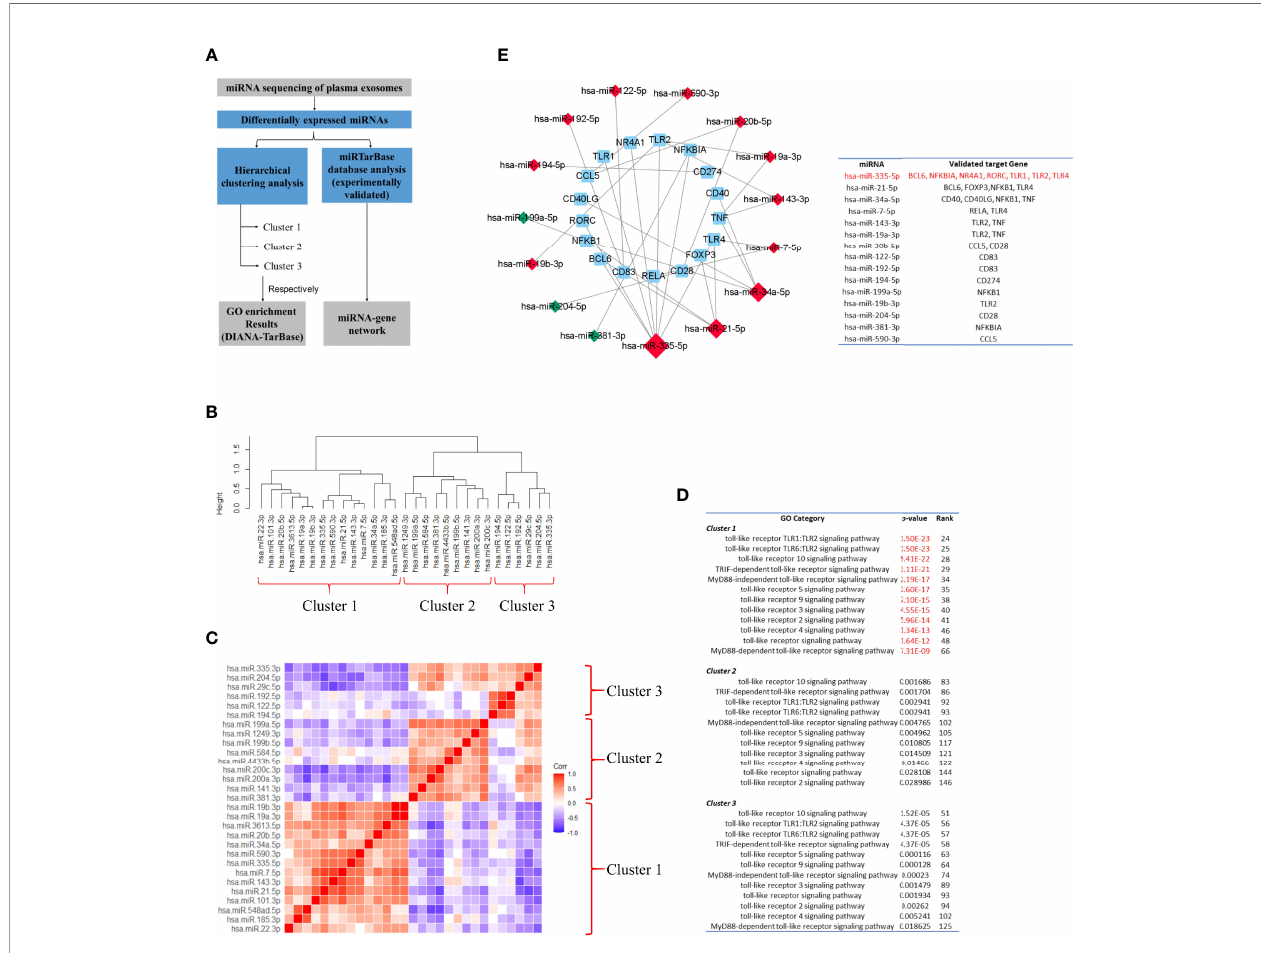
FIGURE 12 | Toll-like receptor signaling pathway might be one of the major targets of the differentially-expressed-miRNA-mediated regulation. (A) Work fl ow of miRNA sequencing analysis. miRNA was from plasma exosomes in Takayasu ’ s arteritis (TAK) patients (n=10) and healthy controls (n=5). (B) The hierarchical clustering trees of miRNA expression level based on Spearman correlation coef fi cient using complete method. (C) The hierarchical clustering heatmaps of miRNA expression level based on Spearman correlation coef fi cient. (D) GO enrichment analysis for each cluster based on DIANA-TarBase, an experimentally validated database. The results indicated that TLR signaling pathway might be one of the major targets of the differentially expressed miRNA-mediated regulation, especially of the miRNAs belonging to Cluster 1. (E) Differentially expressed miRNAs. The miRNA-Gene-network based on miRTarBase database, an experimentally validated database, and the screening condition of “ support type ” was set to “ Functional MTI (miRNA target-interactions). Red and green colors of miRNA indicated upregulation and downregulation, respectively. The results demonstrated that differentially expressed miRNAs that targeted multiple selected genes do exist in TAK, and TLRs, BCL6, and FOXP3 might be regulated by common miRNAs in